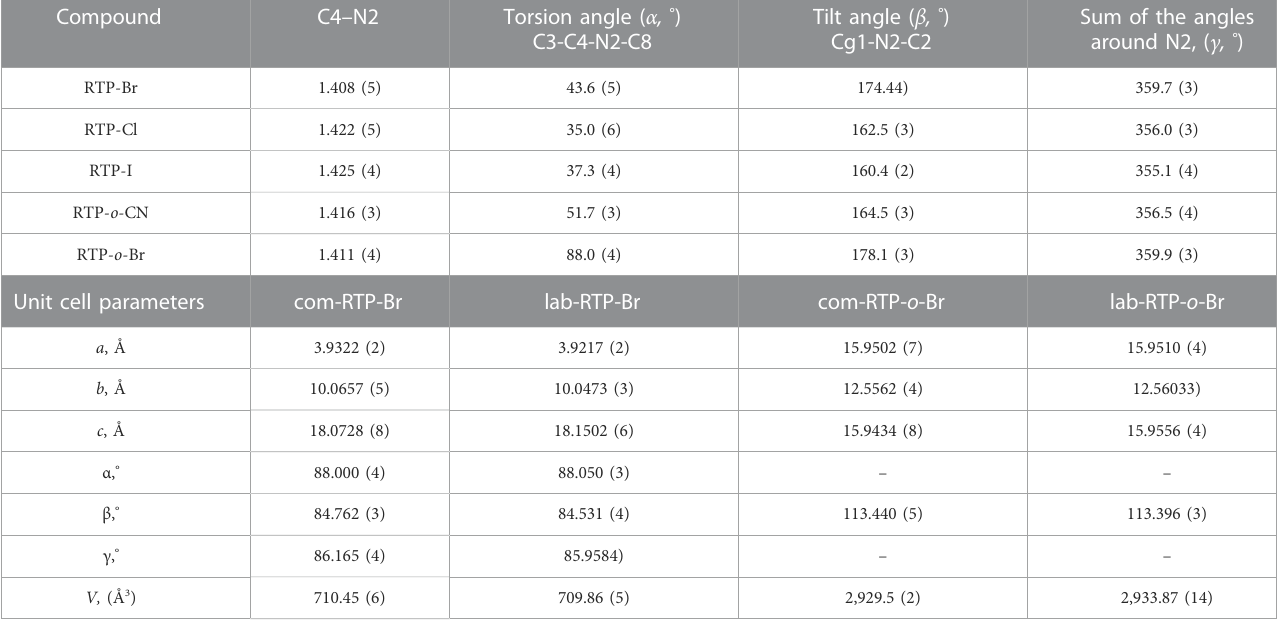
TABLE 1 General numbering scheme, selected bond lengths [Å], and angles [ ° ] for all compounds and unit cell parameters for the RTP-Br and RTP- o -Br materials obtained from the commercial and laboratory synthesized carbazole